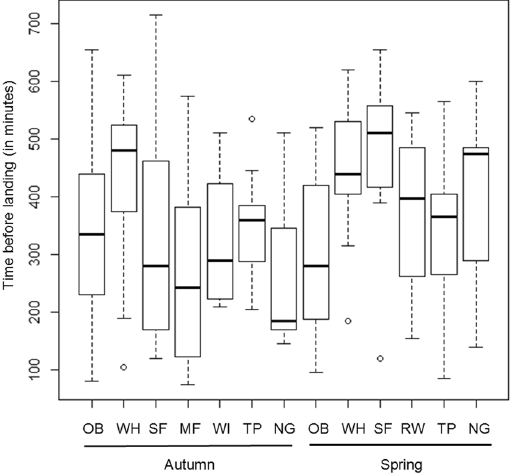
Figure 5. Boxplot of the time of landing after sunrise for days with FLPs not lasting a complete day, during the autumn (7 species) and spring (6 species) migrations. Average, box of 25 th and 75 th quartiles, and 5%-95% confidence intervals, with dots showing potential outliers. Labels of the x-axis are codes for species names: OB: ortolan bunting, WH: whinchat, SF: spotted flycatcher, MF: Mediterranean flycatcher, WI: willow warbler, RW: Eurasian reed warbler, TP: tree pipit, NG: nightingale.